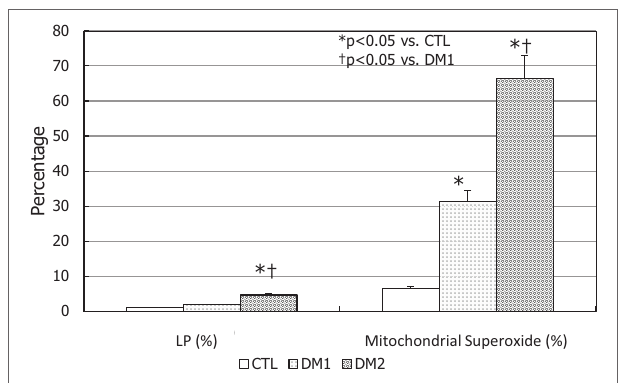
FigUre 5 | Lipid peroxidation (LP) and mitochondrial superoxide concentrations type 1 diabetes mellitus (DM1), type 2 diabetes mellitus (DM2), and controls (CTL) in seminal fluid. * p < 0.05 vs. CTL; † p < 0.05 vs. DM1. The results are expressed as mean ±